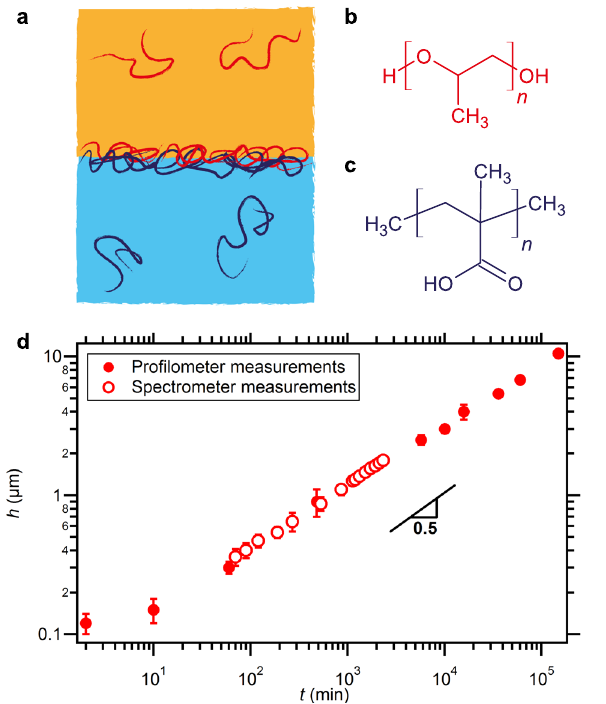
Figure 1. ( a ) Schematic of direct interfacial complexation between an oil phase (orange) and a water phase (blue). Each phase contains a polymer: ( b ) oil-soluble poly(propylene oxide) (PPO), and ( c ) water-soluble poly(methacrylic acid) (PMAA). A membrane is formed at the interface by H-bond complexation of the two polymers. ( d ) Evolution of the membrane thickness h over time t . Measurements are performed by two methods: in situ spectrometry (empty circles) and ex situ profilometry (filled circles). Error bars are shown when larger than markers